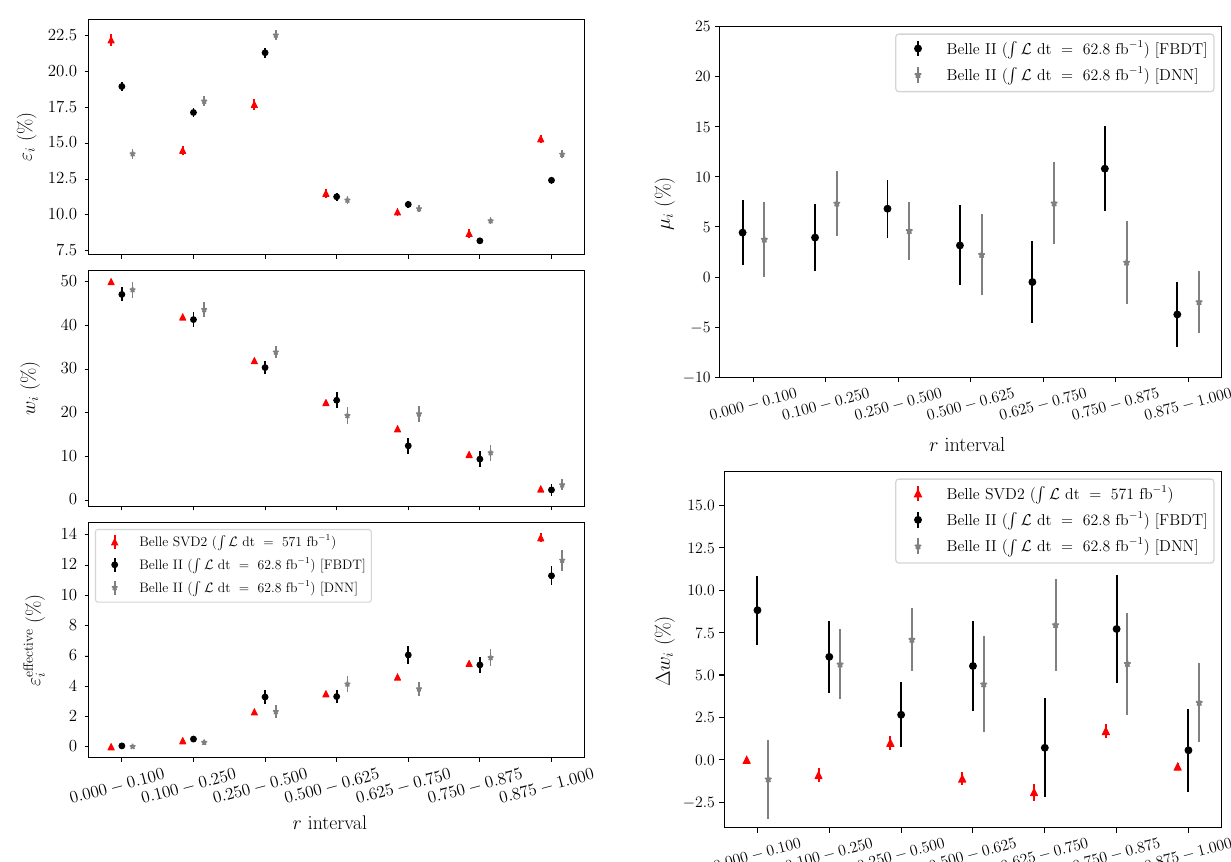
Fig. 14 Performance of the Belle II category-based (FBDT) and deep- learning (DNN) flavor taggers in 2019–2020 Belle II data and of the Belle flavor tagger in 2003–2010 Belle data [33] taken with the second silicon-vertex detector configuration (SVD2) Fig. 15 Comparison of (top) tagging efficiency asymmetries μ i and (bottom)wrong-tagfractionasymmetries Δw i fortheBelleIIcategory- based (FBDT) and deep-learning (DNN) flavor taggers in 2019–2020 BelleIIdataandfortheBelleflavortaggerin2003–2010Belledata[33] taken with the second silicon-vertex detector configuration